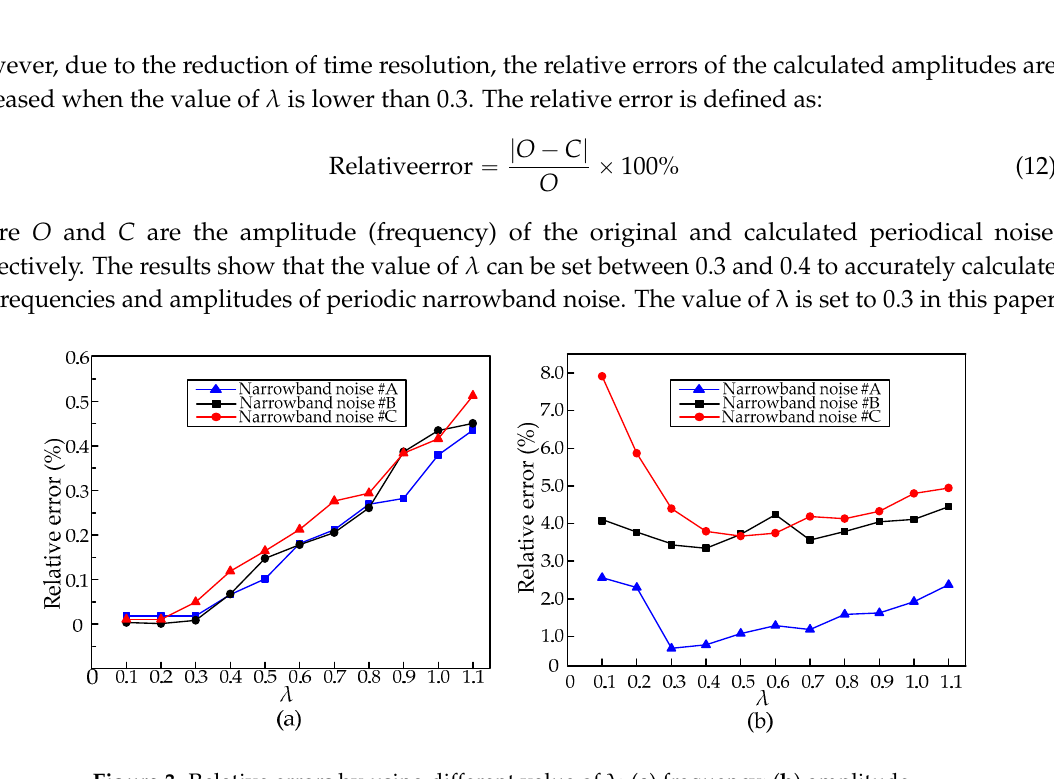
Figure 3. Relative errors by using different value of λ : ( a ) frequency; ( b ) amplitude.